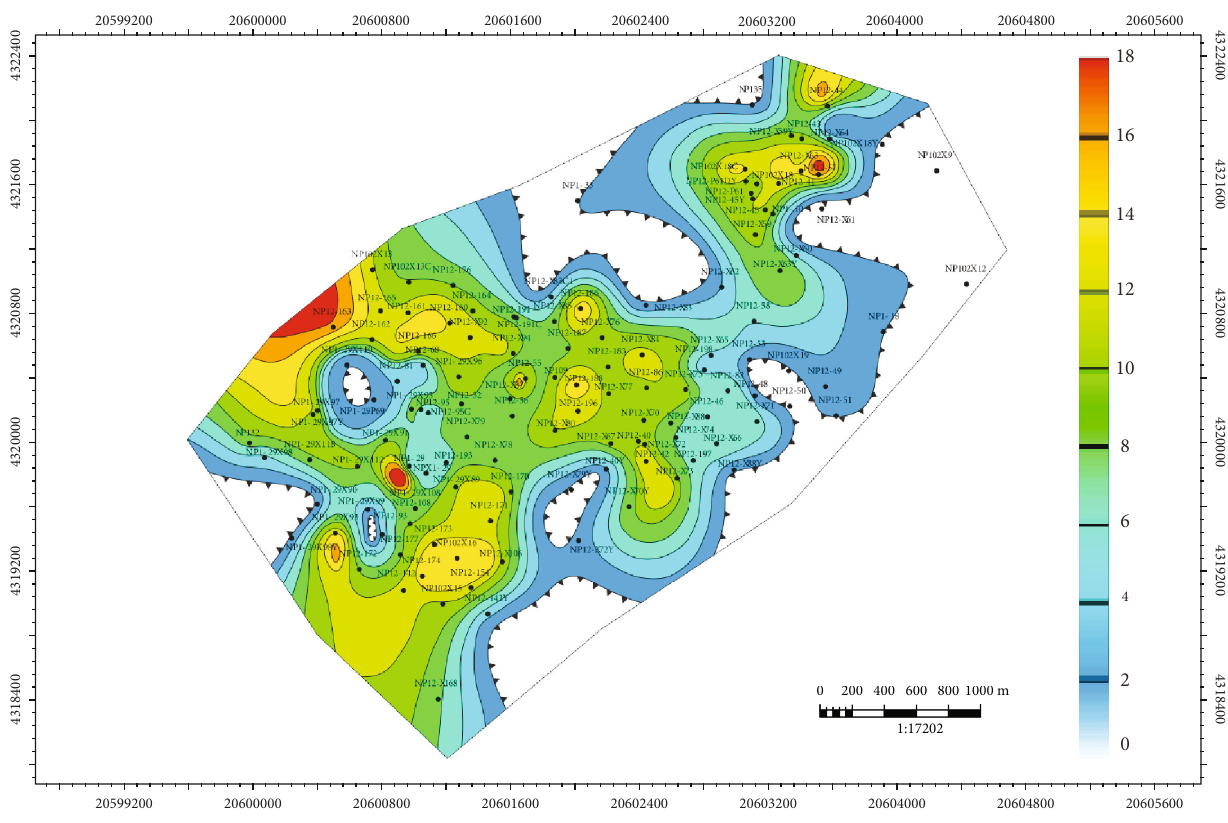
Figure 5: Contour map of NgIV ② 6-1 sand thickness in Nanpu 1-29 Area.